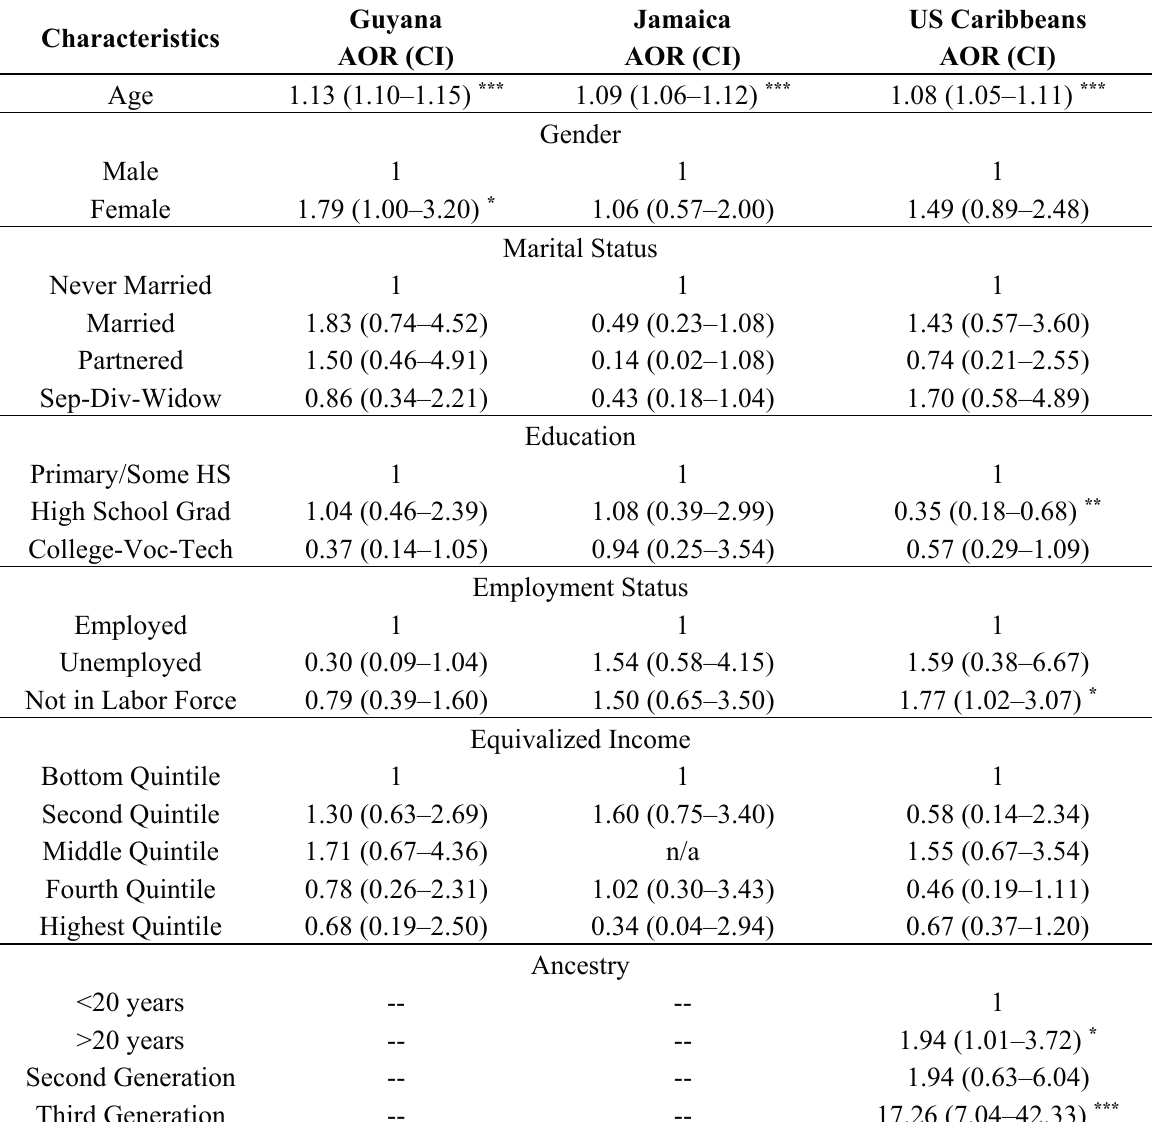
Table 8. Factors associated with lifetime prevalence of arthritis by